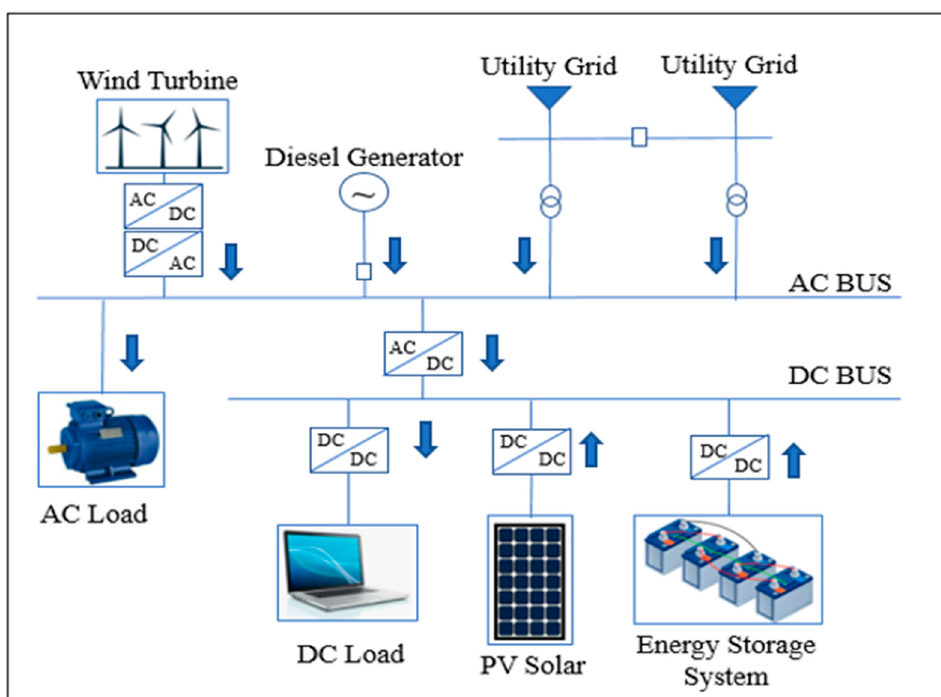
Figure 5. Hybrid AC/DC MG architecture.